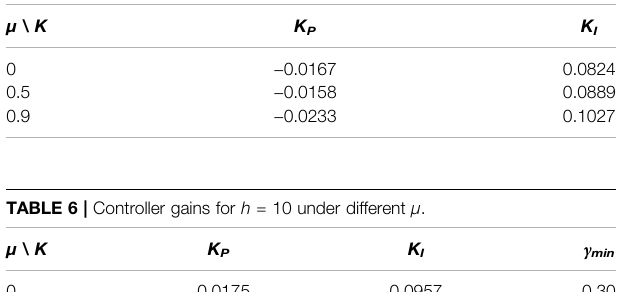
TABLE 5 | Controller gains for h (cid:2) 10 under different μ .